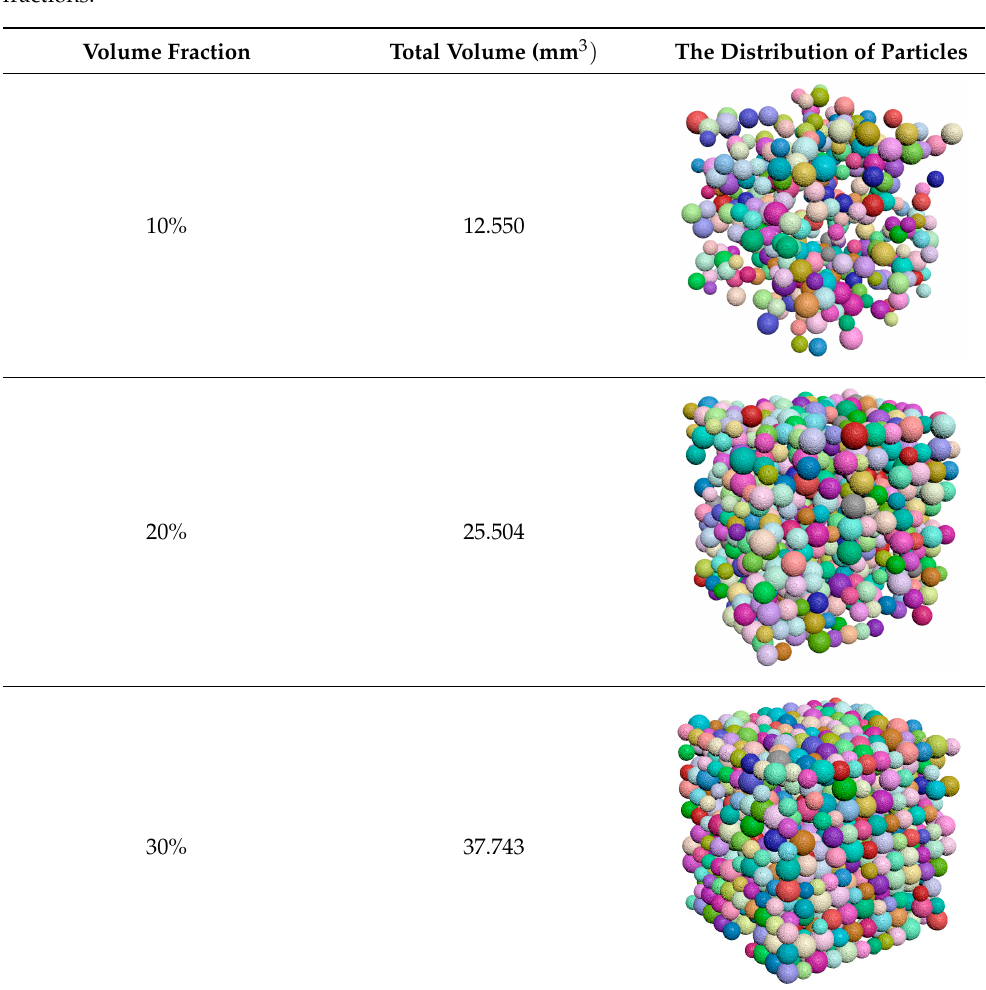
Table 2. Distribution effects of particles with the same probability density and different volume fractions.